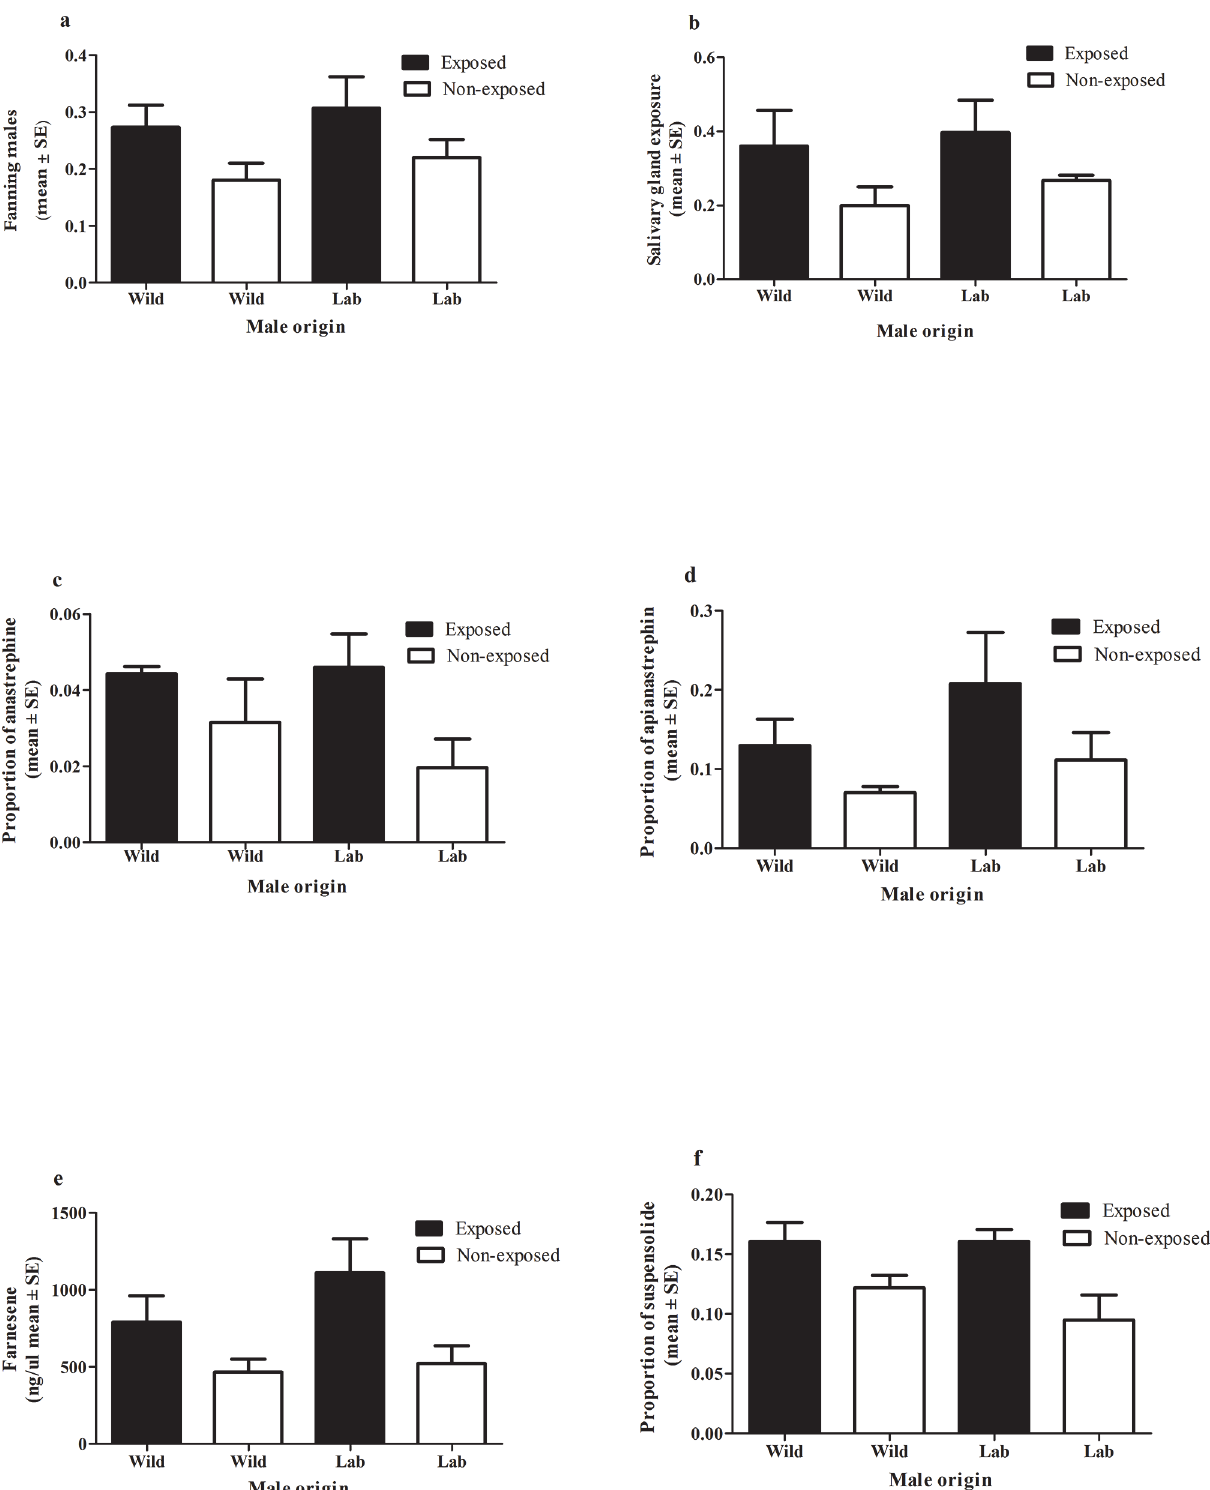
Fig 2. Effect of guava exposure on male calling behavior and pheromone release. a) Number of males that were detected fanning their wings across the observational period (mean ± SE) (mixed effect model P < 0.001). b) Number of males that were detected exposing their salivary glands across the observational period (mean ± SE) (mixed effect model P = 0.076). c) Anastrephin released per male (mean proportion to (E , E) - α -farnesene ± SE) (mixed